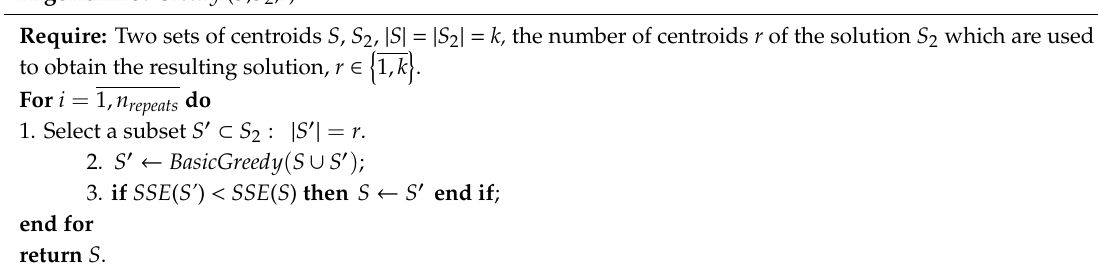
Algorithm 3. Greedy ( S , S 2 , r